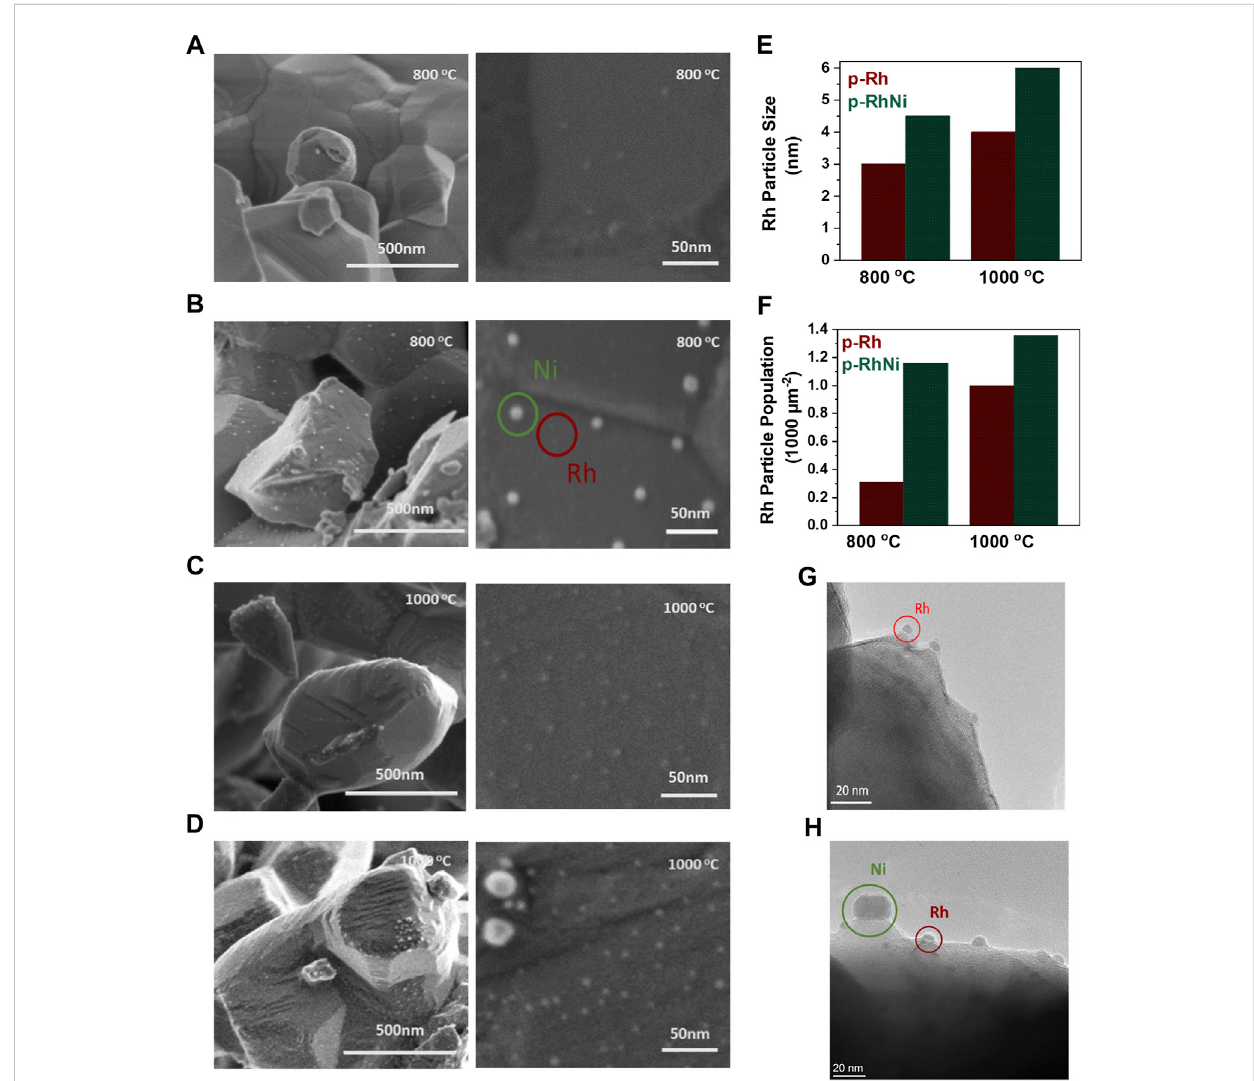
FIGURE 3 Micro and nanostructure of the exsolved catalysts: (A) Rh 3 reduced at 800 ° C (B) Rh 3 Ni 3 reduced at 800 ° C (C) Rh 3 reduced at 1,000 ° C (D) Rh 3 Ni 3 reduced at 1,000 ° C (E) Particle size of the Rh exsolved particles of the reduced catalysts calculated from SEM images (F) Population of the Rh exsolved particles of the reduced catalysts calculated from SEM images (G) TEM image of Rh 3 (H) TEM image of the Rh 3 Ni 3